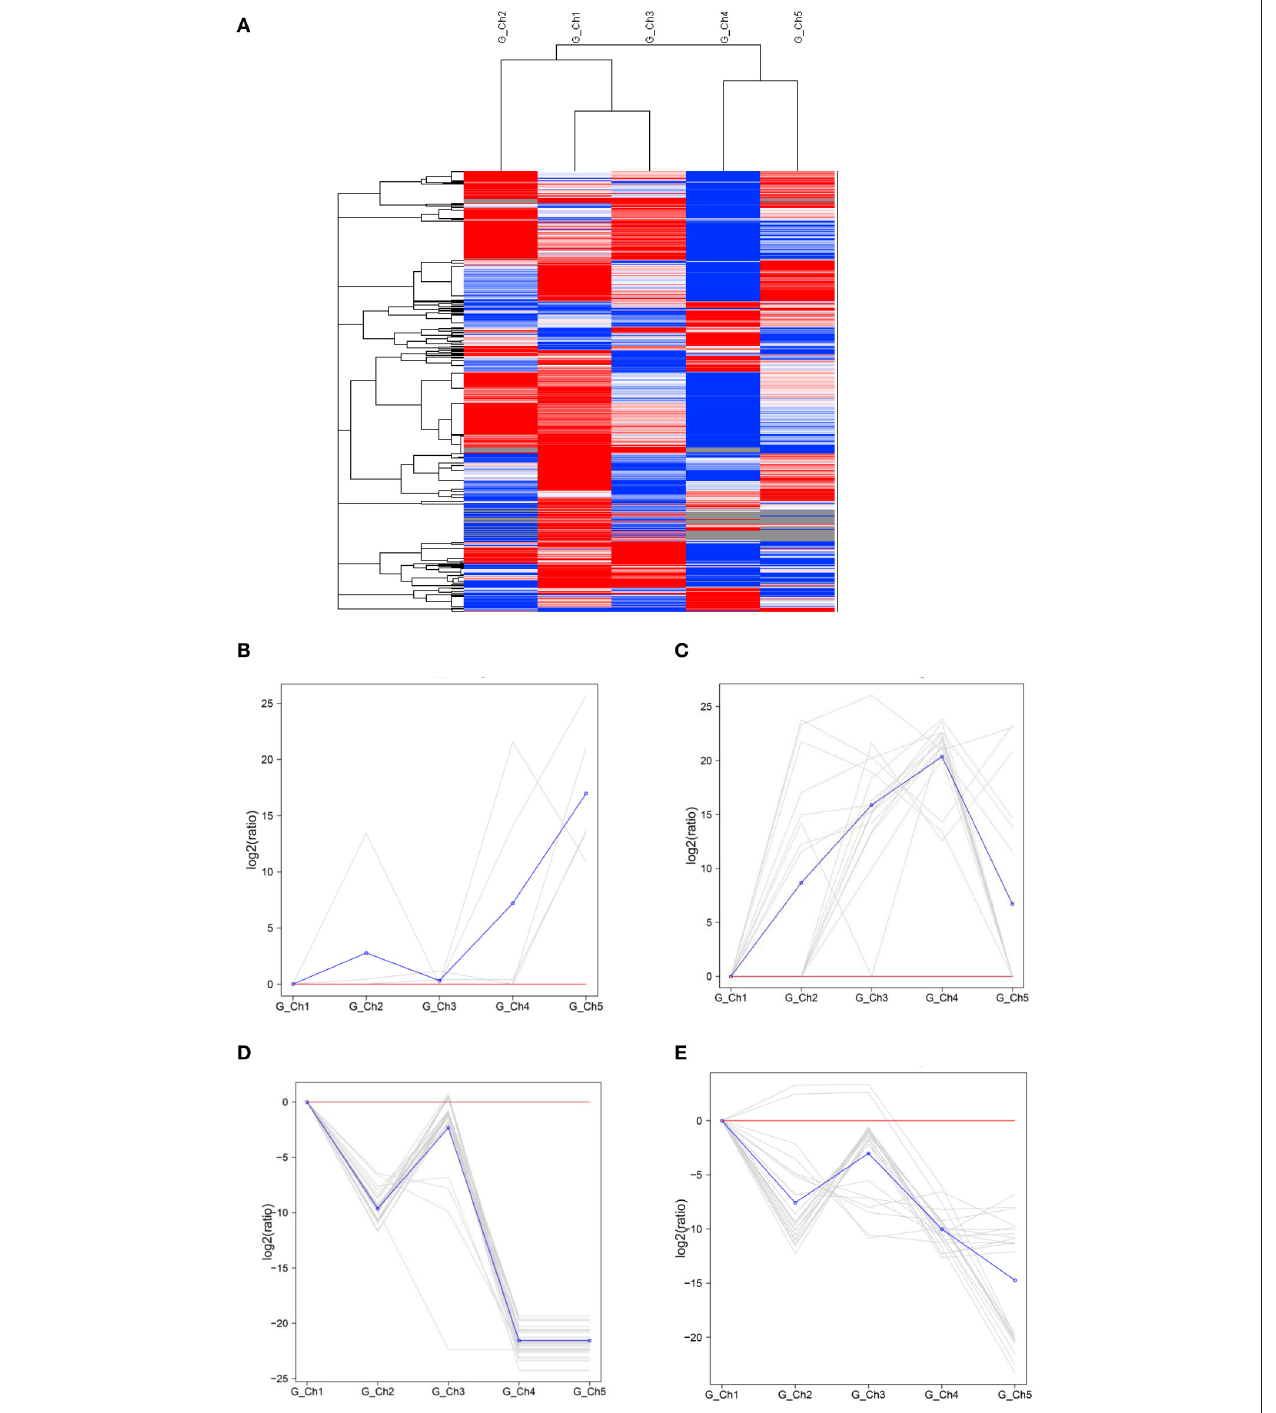
FIGURE 4 | Gene expression patterns of Chorthippus albonemus in response to different levels of grazing intensity. (A) Clusters of differentially expressed genes. Red indicates upregulated genes, blue indicates downregulated genes, and white indicates no difference in gene expression. Differences in color intensity indicate higher or lower expression [log 10 (FPKM + 1)]. Two patterns were observed for upregulated gene expression, involving (B) a cluster of five genes and (C) a cluster of 16 genes. Two patterns were observed for downregulated gene expression, involving (D) a cluster of 30 genes and (E) a cluster of 23 genes. The gray lines indicate gene expression under different grazing intensities relative to the no grazing control [gene log 2 (ratios)], and the blue lines indicate average relative expression of all genes in the cluster. Significant differential expression was set at q < 0.005, |log 2 fold change| > 1. G_Ch1 to G_Ch5 indicate grazing intensity, namely, no grazing (G_Ch1), light grazing (G_Ch2), moderate grazing (G_Ch3), heavy grazing (G_Ch4), and overgrazing (G_Ch5), respectively.